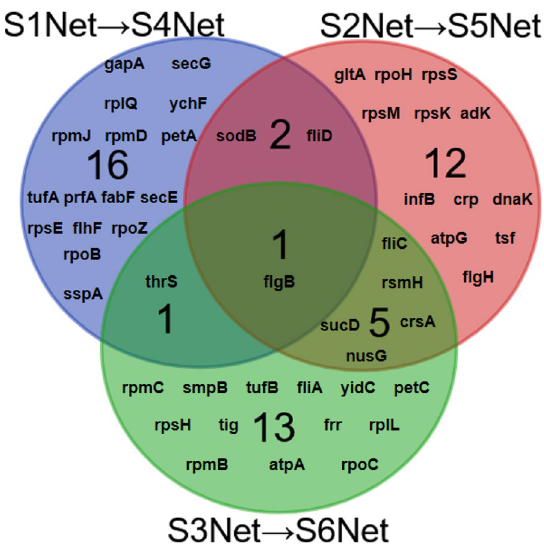
Fig. 4 Relationship of genes identified by node centrality changes for three pairs of active